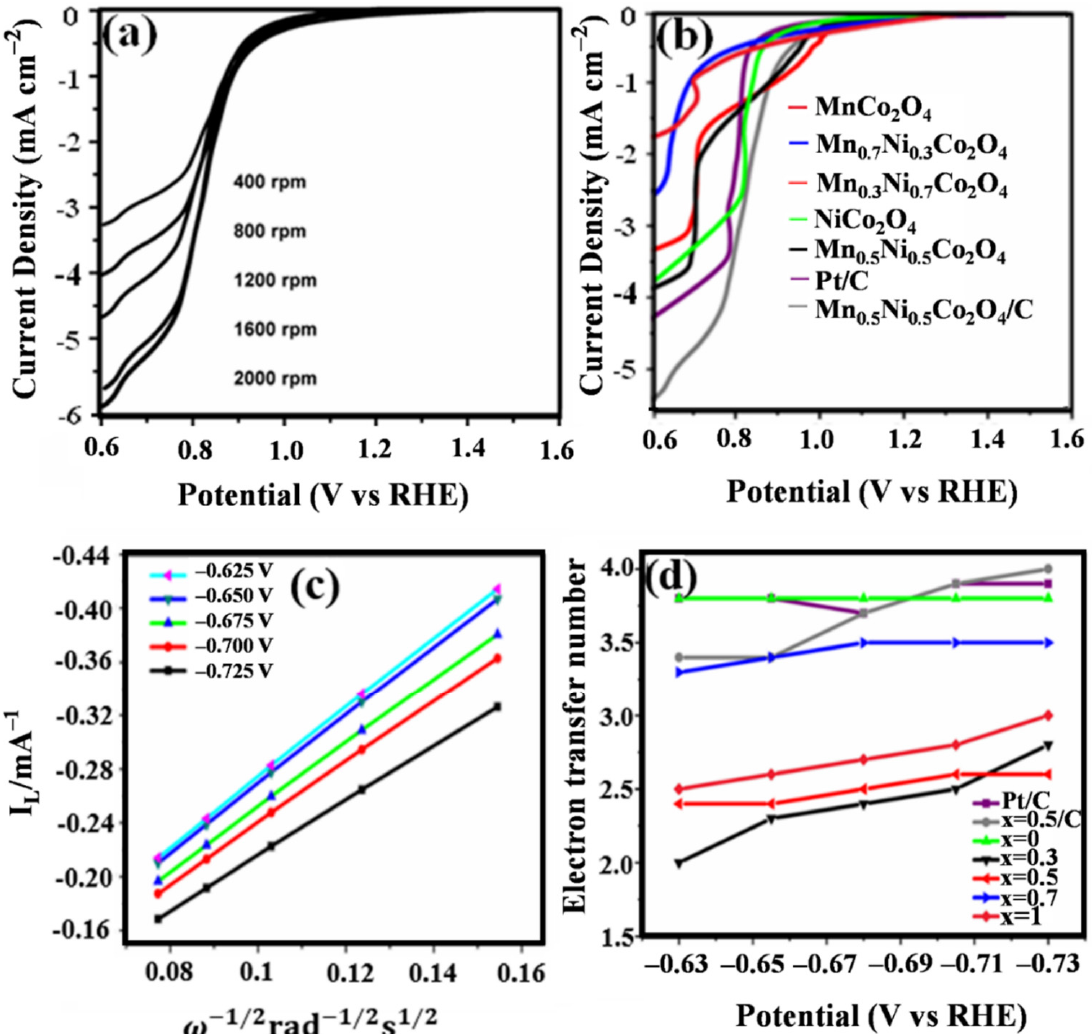
Figure 8. ( a ) LSV curves of the Mn 0.5 Ni 0.5 Co 2 O 4 /C nanosheets in an O 2 -saturated 0.1 M KOH solution at different rotation speeds (scan rate: 10 mV s − 1 ), ( b ) RDE curve comparison in oxygen saturated 0.1 M KOH at 1600 rpm at a cathodic sweep of 10 mV s − 1 , ( c ) the Koutecky–Levich plots, and ( d ) number of electrons transferred plots. For the commercial application of the electrocatalysts, durability and lifespan studies are important. To this end, 405 scan cycles were performed within the 0.55 to 1.35 (V vs. RHE) range in O 2 -saturated KOH (aq), and the potential sweep voltammograms shown in Figure S10 were produced. After 405 scan cycles, a shift in current peaks characterized by current reduction was observed. Of all the synthesized Mn x Ni 1 − x Co 2 O 4 series (Figures S10a–f), Mn 0.5 Ni 0.5 Co 2 O 4 was found to possess the least current loss (0.21%; Figure S10c) and MnCo 2 O 4 the highest current loss of 17.03% (Figure S10e). At 0.11%, Mn 0.5 Ni 0.5 Co 2 O 4 /C had the smallest current loss (Figure S10f). The stability during the cyclization is ascribed to the Mn 0.5 Ni 0.5 Co 2 O 4 and carbon sheet interaction. The current loss of the electrocatalysts followed the following order: Mn 0.5 Ni 0.5 Co 2 O 4 /C < Mn 0.5 Ni 0.5 Co 2 O 4 < NiCo 2 O 4 < Mn 0.3 Ni 0.7 Co 2 O 4 < Mn 0.7 Ni 0.3 Co 2 O 4 < MnCo 2 O 4 (Table S3). This high durability is also at- tributed to the alkaline electrolyte because the presence of hydroxide ions in solution en- hances metal hydroxide (M–OH) formation, stabilizing the cyclic voltammetry [64].